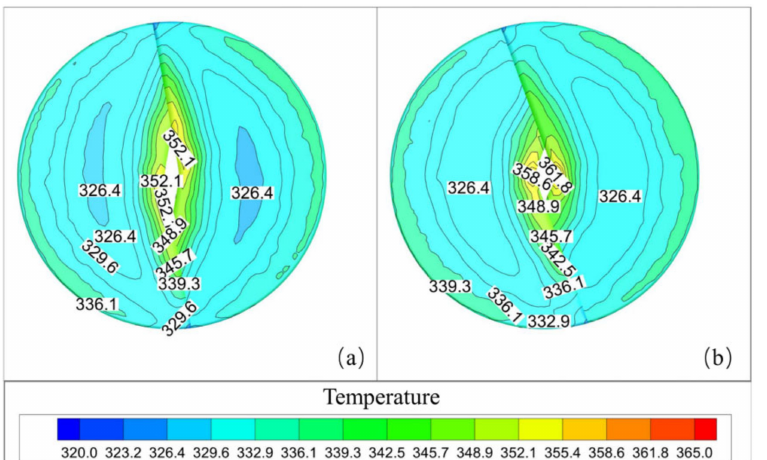
Figure 18. 10 ◦ cross angle susceptor optimization results: ( a ) chamfer-optimized; ( b ) not chamfer-